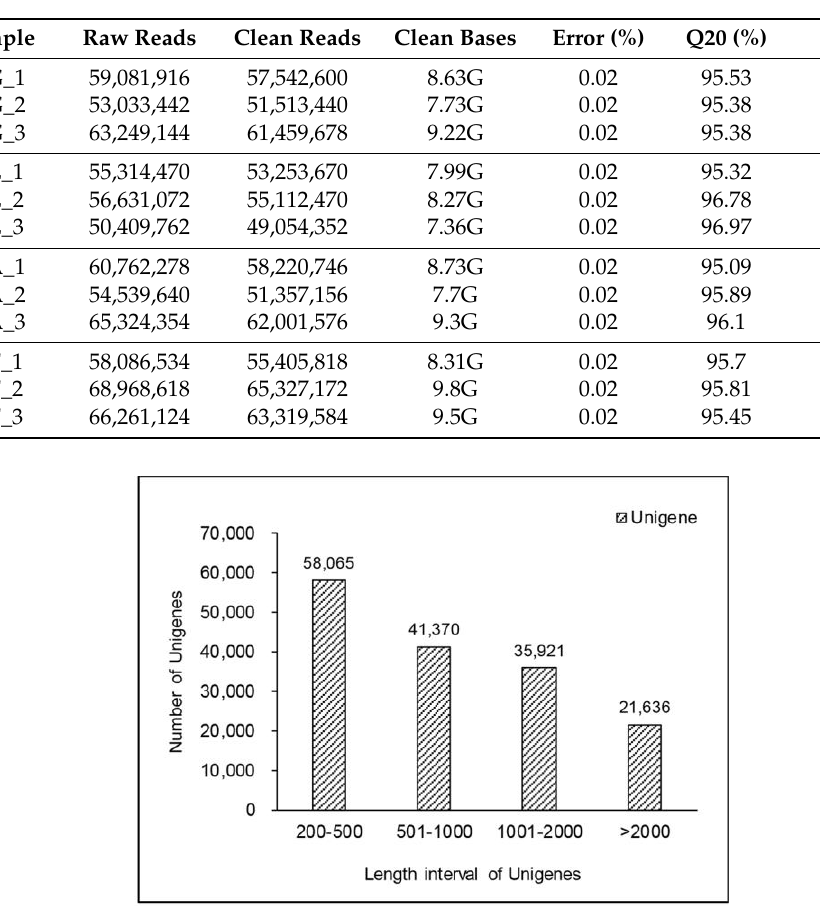
Table 1. List of data output quality.